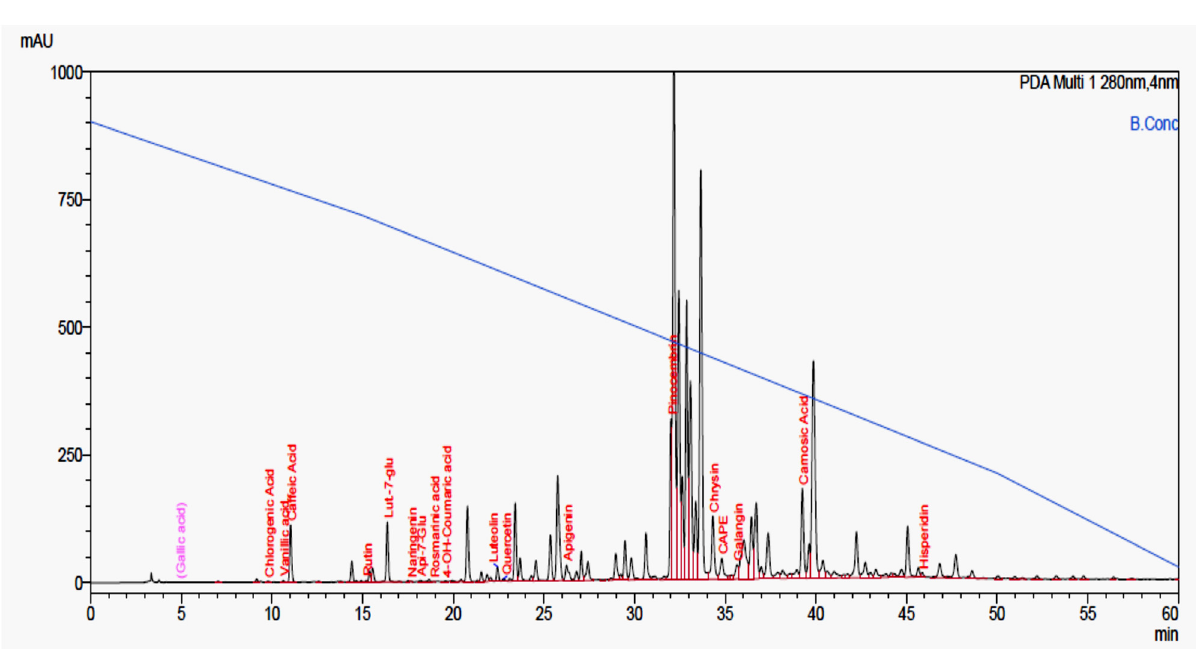
Figure 2. HPLC-PDA analysis of Jordanian propolis sample (70% ethanolic extract), showing different identified chemical constituents.